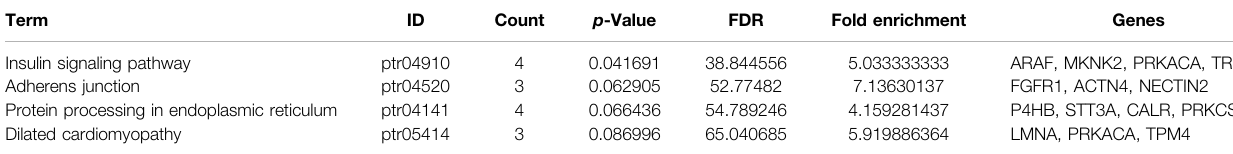
TABLE 3 | Kyoto Encyclopedia of Genes and Genomes (KEGG) pathway analysis for predicted co-expression genes of SYDE1 in gliomas. Term